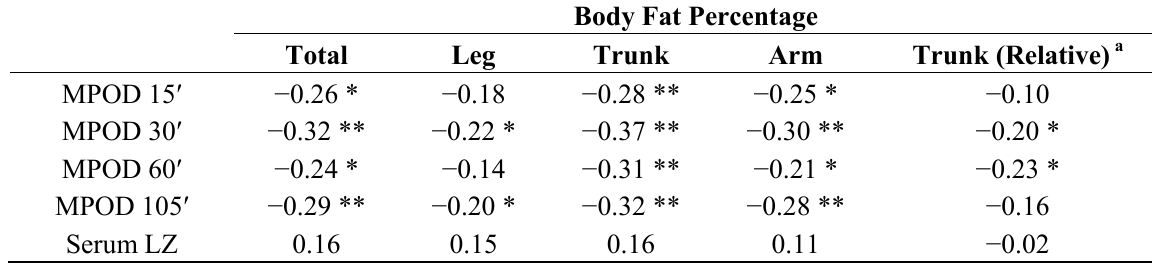
Table 2. Pearson-product moment correlation coefficients for associations between body fat percentage and LZ status.